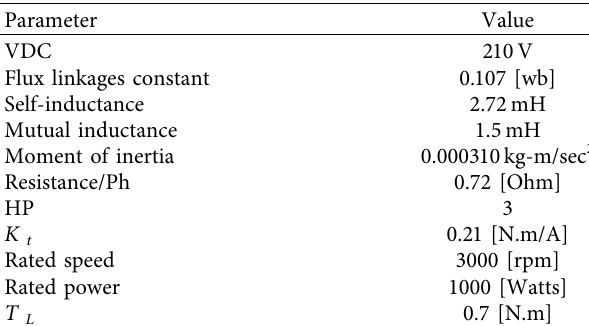
Table 1: Parameters of the BLDCM.